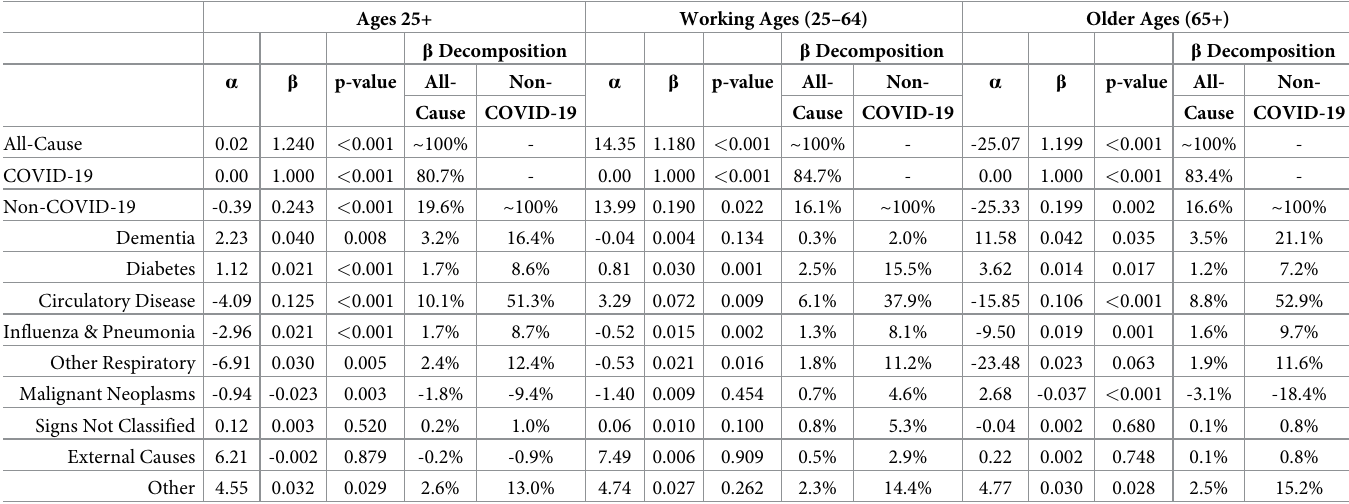
Table 3. Regression of state-level change in cause-specific mortality on COVID-19